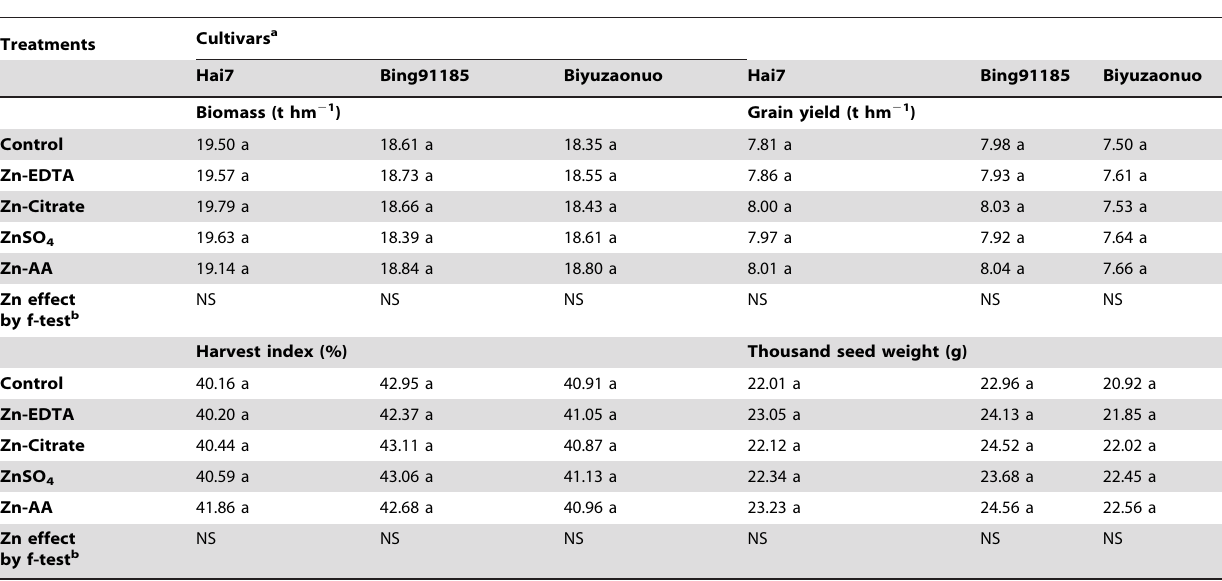
Table 2. Effect of different forms of foliar Zn fertilization on the biomass, grain yield, harvest index and thousand seed weight of three rice